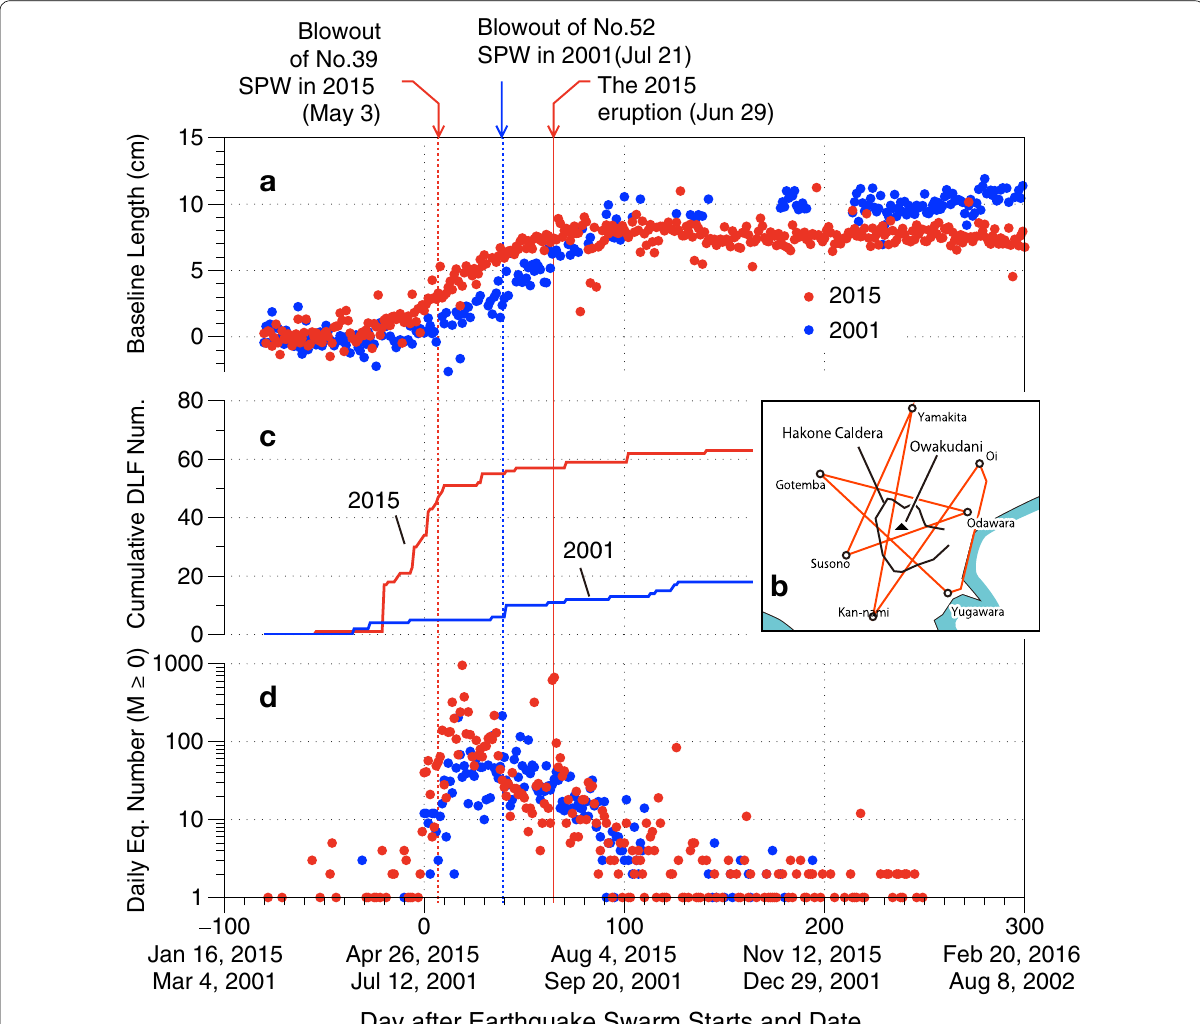
Fig. 5 Sequential changes of crustal inflation and seismic activity during the 2001 unrest and 2015 eruption (Harada et al. 2015). a Crustal infla- tion is represented by normalized baseline lengths across the volcano (the stacking method; Miyaoka et al. 2011; Miyaoka and Takagi 2016). The baselines used in a are shown in b . c Cumulative number of deep low-frequency event (DLF). d Seismic activity is represented by daily number of earthquakes at Hakone volcano (